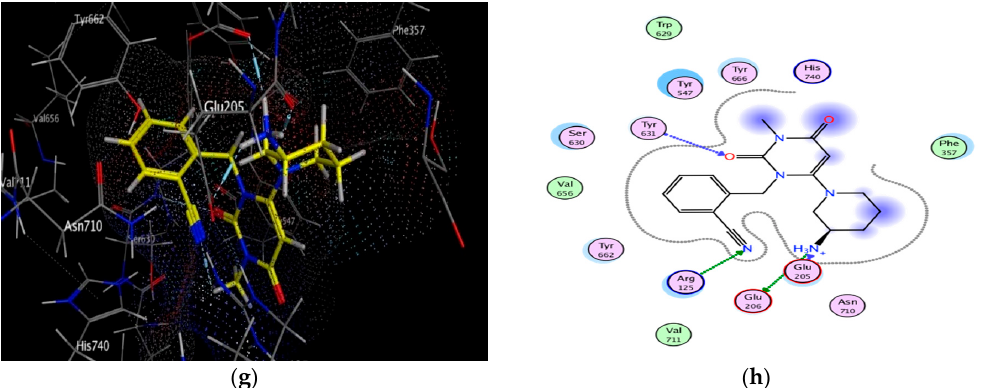
Figure 6. Docking and binding pattern of compounds 10g ( A & B ), 10i ( C & D ), 10e ( E & F ) and alogliptin ( G & H ) showing interactions with different amino acid residues found in the active site of DPP-4 (PDB code: 3G0B).